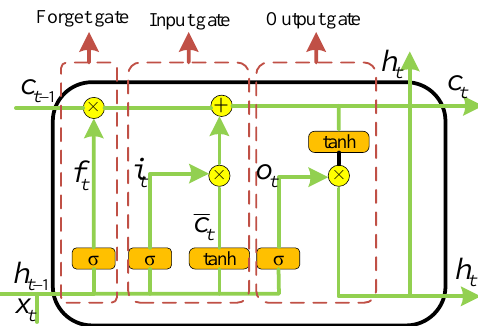
Figure 6. The architecture of a Long Short-Term Memory (LSTM) cell.